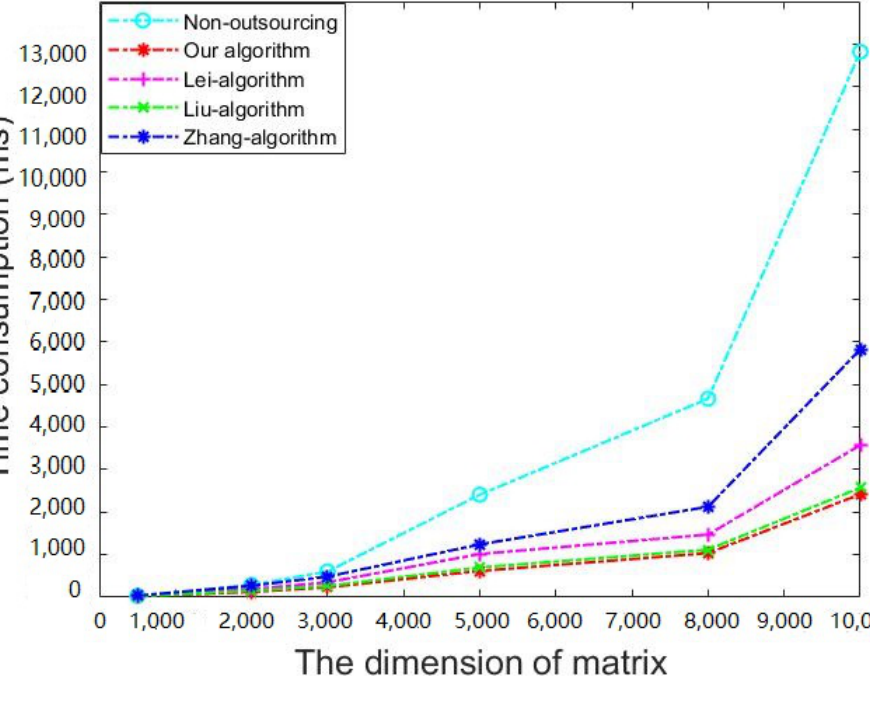
Figure 4. The time consumption of the